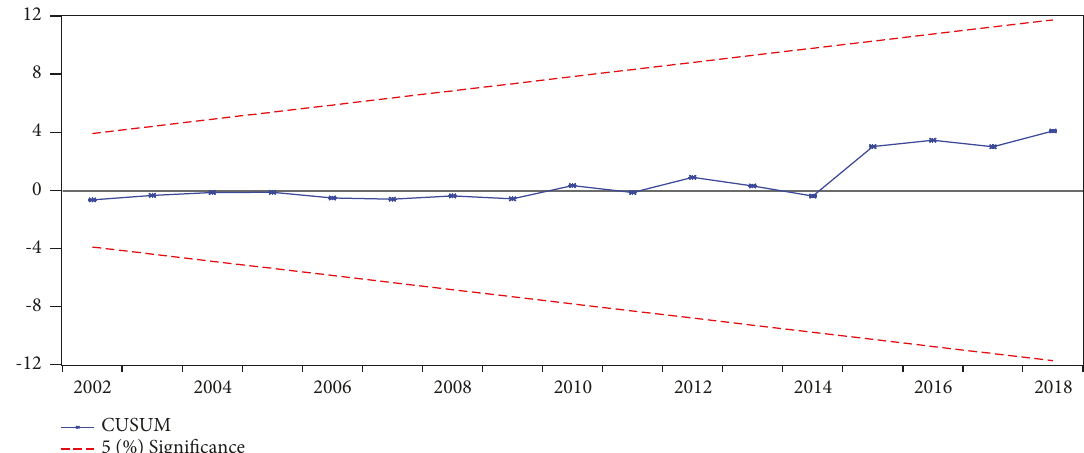
Figure 5: Results of the stability test. Source: authors’ own